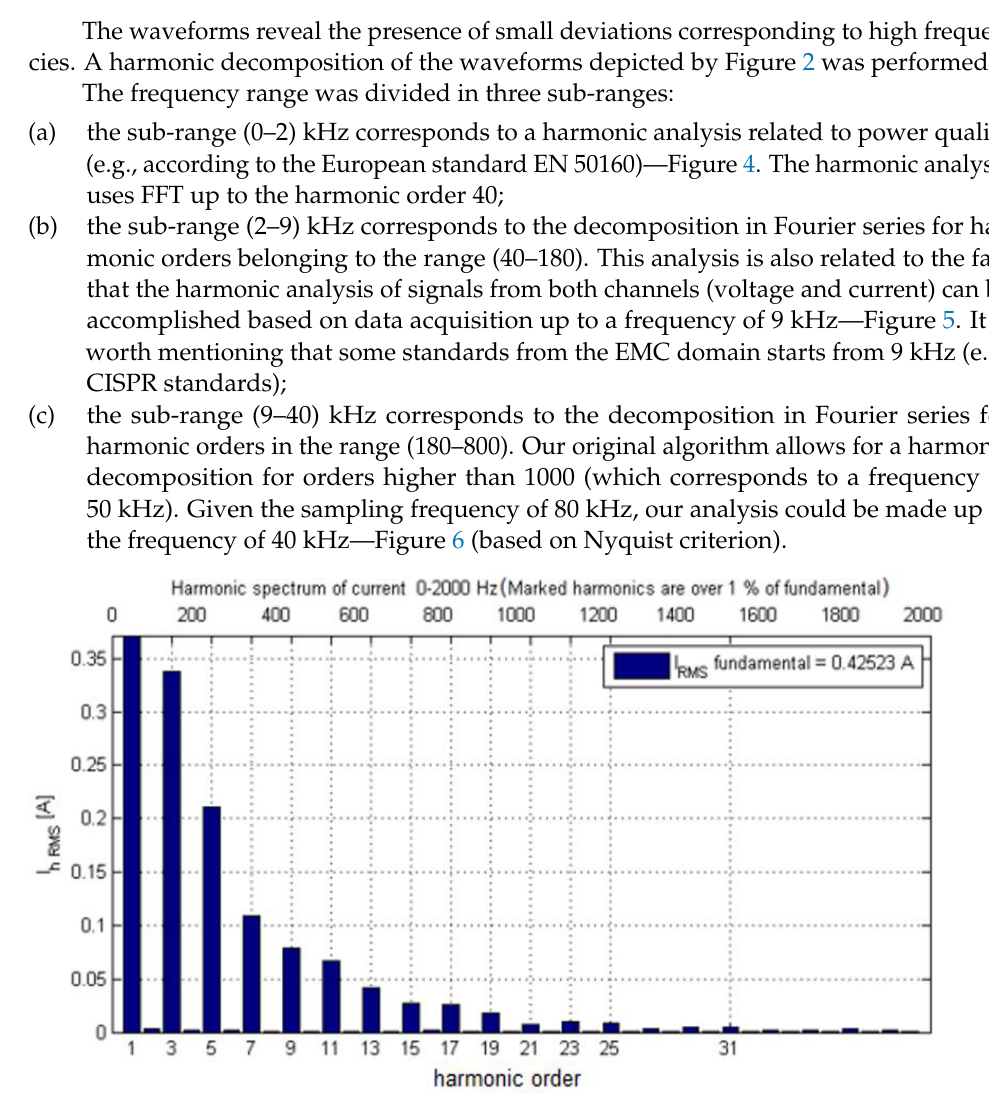
Figure 4. Harmonic decompositions of current in the range (0–2) kHz. The magnitudes of harmonics for frequencies within the ranges (2–9) kHz and (9–40) kHz are small. Therefore, imposing a minimum threshold for their magnitude as a condition for their consideration (e.g.,—as in the case of PQ problems—Figure 4) should result in their neglect. Despite the questionable accuracy in evaluating them, our analysis revealed harmonic currents with magnitudes of x µ A or even x mA (as in Figures 5 and 6). These currents can interfere with other currents of common or differential mode and EMIs might be generated. As the load is highly variable, these currents are submitted to significant variations too, and therefore a deeper analysis concerning them should be made. The voltage and absorbed current were decomposed in the frequency domain with FFT and allowed us to determine some electrical parameters and quality indices [12,24]. They are summarized in Table 1 from the PQ point of